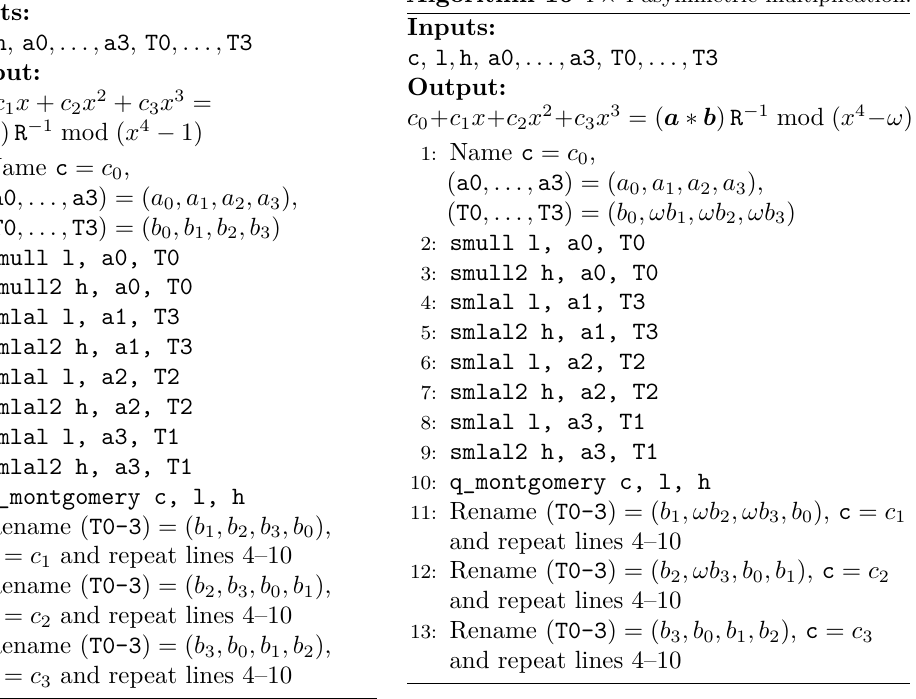
Algorithm 16 4 × 4 asymmetric